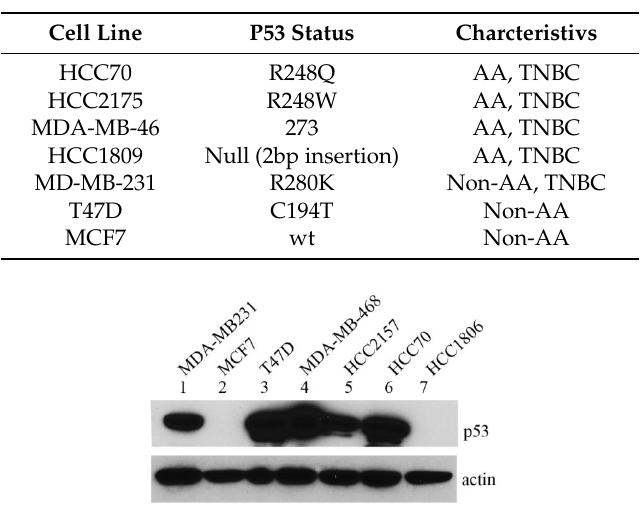
Figure 1. mtp53 is highly expressed in breast cancer cell lines. Expression of p53 protein in a panel of breast cancer cell lines: MDA-MB-231, MCF7, T47D, MDA-MB-468, HCC2157, HCC70 and HCC1806 and (lanes 1–7, respectively). 50 μg of protein extracted from different cell lines using RIPA buffer, were separated by gradient 4%–12% SDS/PAGE and analyzed by western blot using antibody to p53. Actin was used as a loading control. A representative blot is